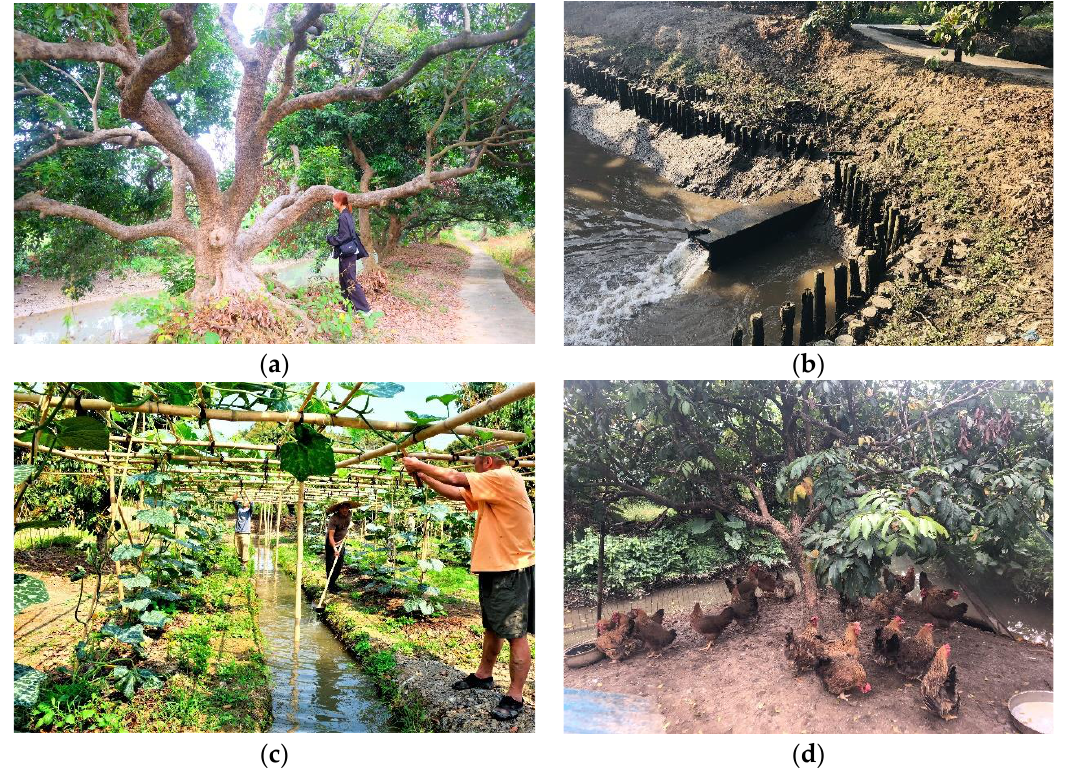
Figure 2. Photos of the HHBLDA: ( a ) Dike, ancient litchi trees, and artificial canal; ( b ) Wooden water gate; ( c ) High bed and low ditch; ( d ) Raising chickens under the fruit tree.